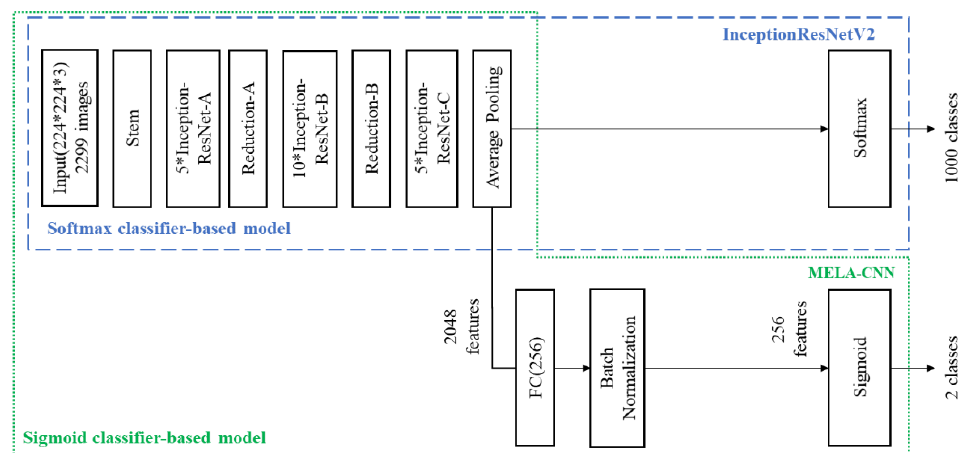
Figure 1. MELA-CNN network architecture.